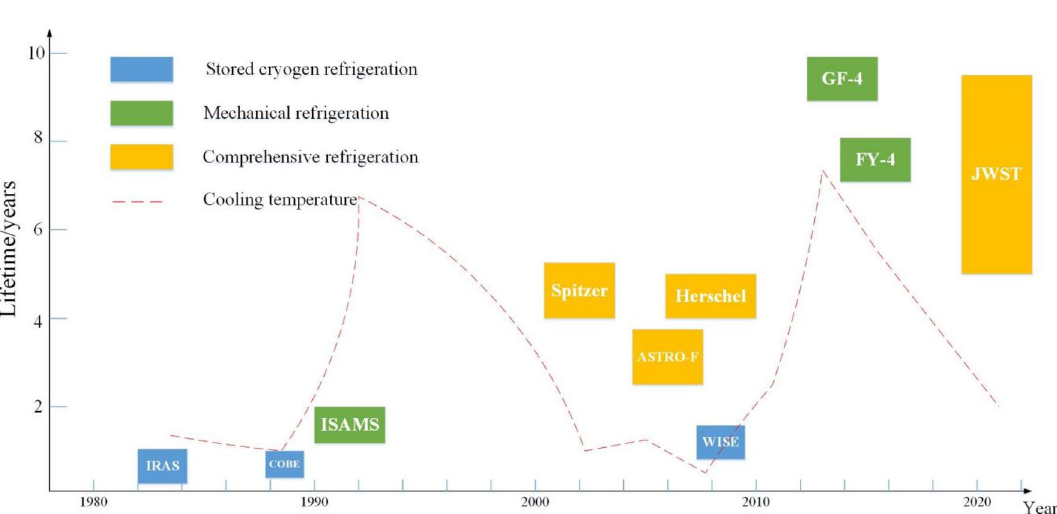
Figure 19. The main cryogenic technologies for space detection and its characteristics 54 (generated by Microsoft Visio 2013 10.0.19043 https:// www. micro soft. com/ zh- cn/ micro soft- 365/ visio/ flowc hart- softw